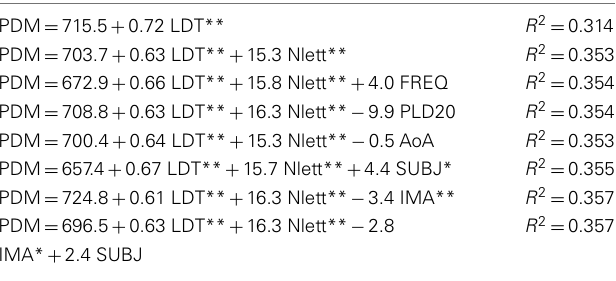
Table 7 |Variables other than lexical decision RT that predict PDM performance (linear regression without